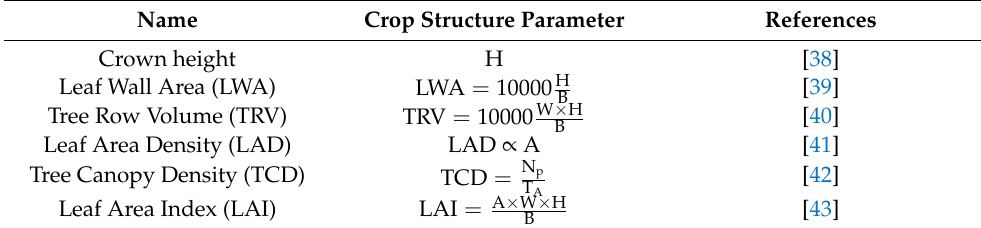
Table 2. Crop structure parameter equations for precision spraying in orchards 1